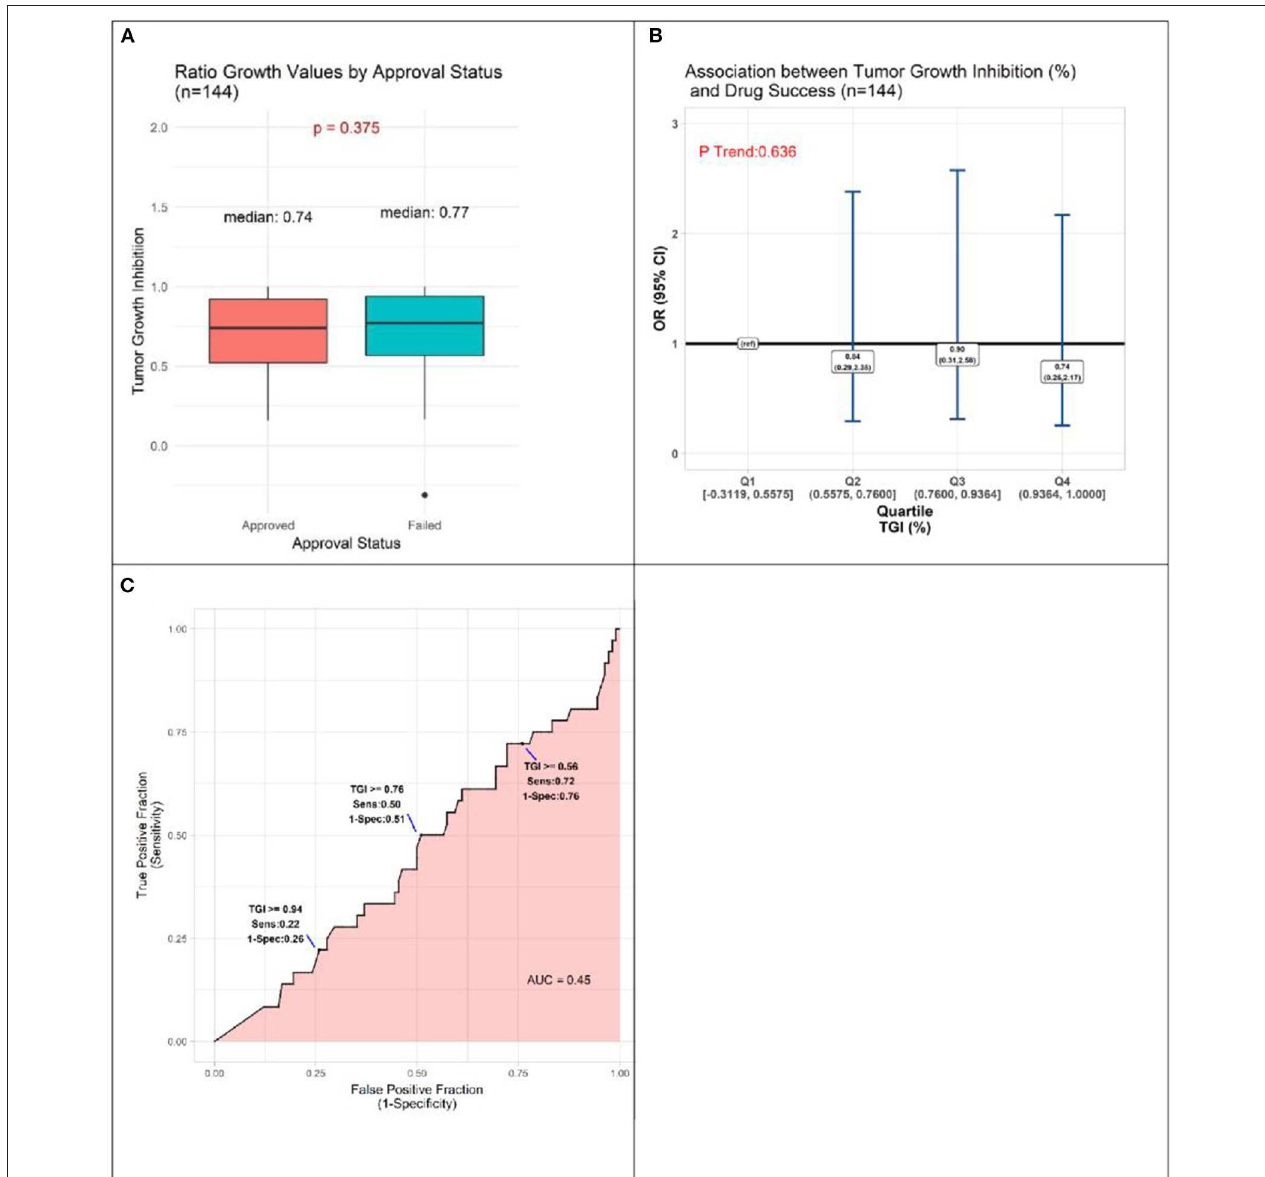
FIGURE 3 | Results of quantitative analyses of preclinical studies in murine models. (A) Box-plots displaying distributions of tumor growth inhibition (TGI) in preclinical murine models of subsequently approved and failed drugs. (B) Odds Ratio (OR) estimates of association between drug success and TGI result of preclinical animal model experiments, drugs with TGI in each of quartiles (Q) Q1, Q2, Q3 compared to those with TGI in Q4 (reference). (C) Receiver operator curve displaying accuracy of TGI value as predictor of drug